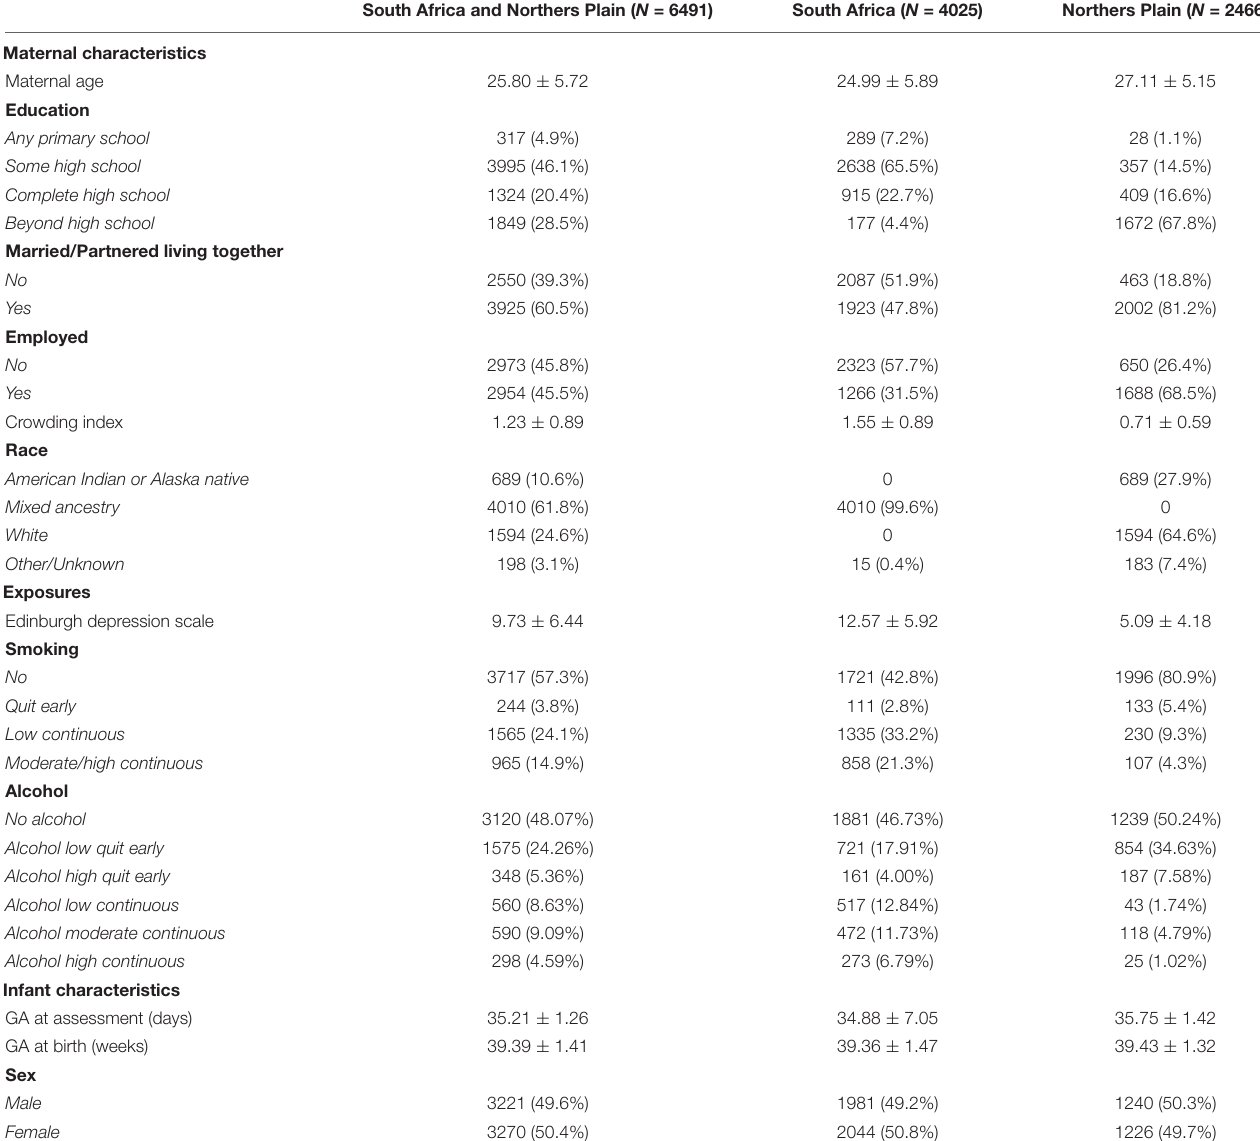
TABLE 1 | Maternal and infant demographics and prenatal exposure information. South Africa and Northers Plain ( N = 6491) South Africa ( N =